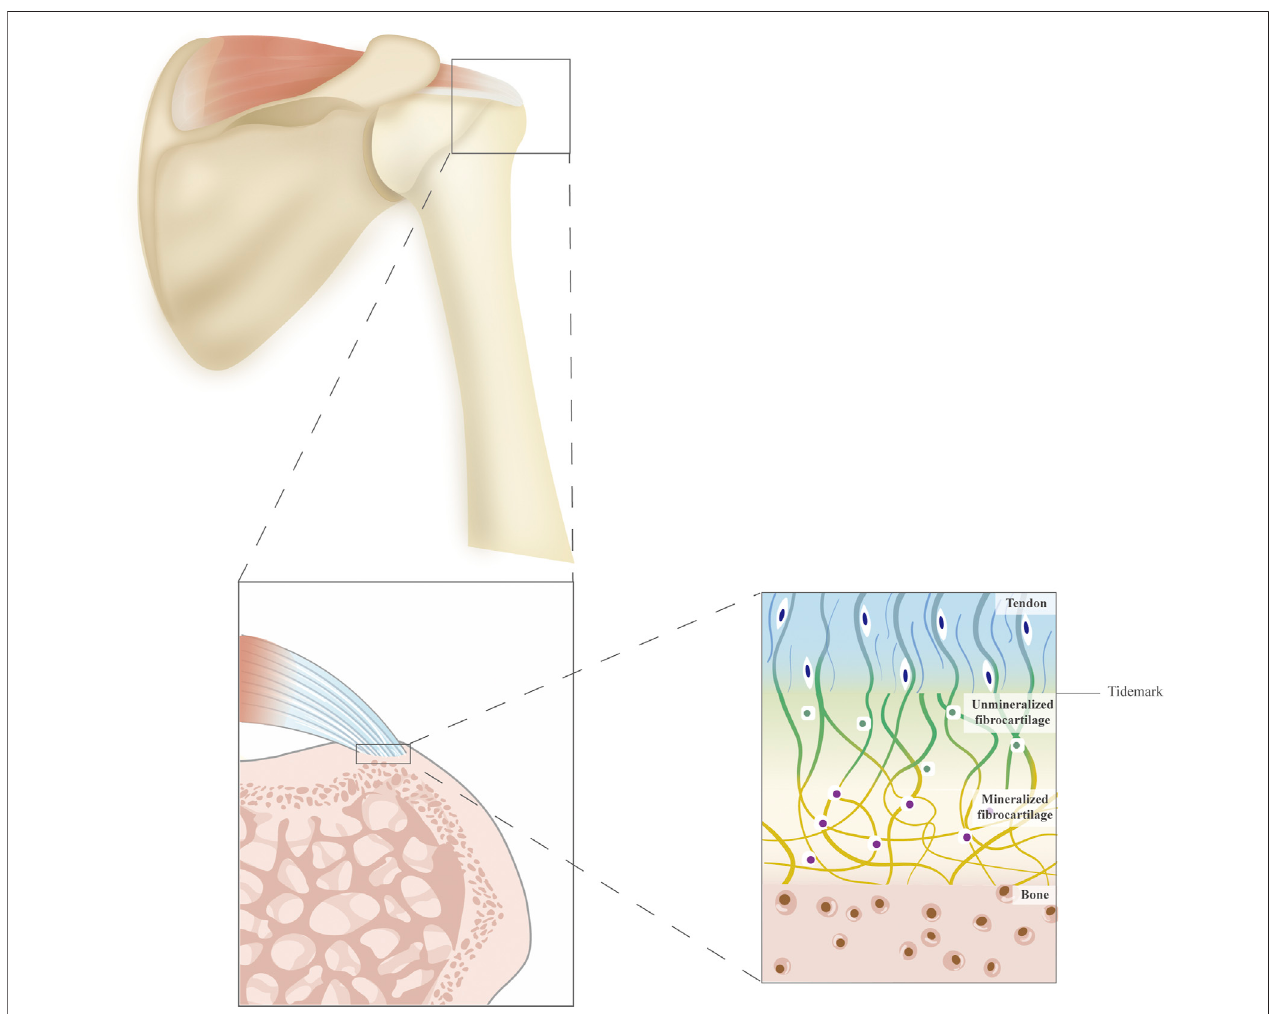
FIGURE 1 | A schematic diagram of the supraspinatus tendon and the structure of the tendon – bone interface. The tendon – bone interface is divided into four continuous but distinct zones: tendon, unmineralized fi brocartilage, mineralized fi brocartilage, and bone.